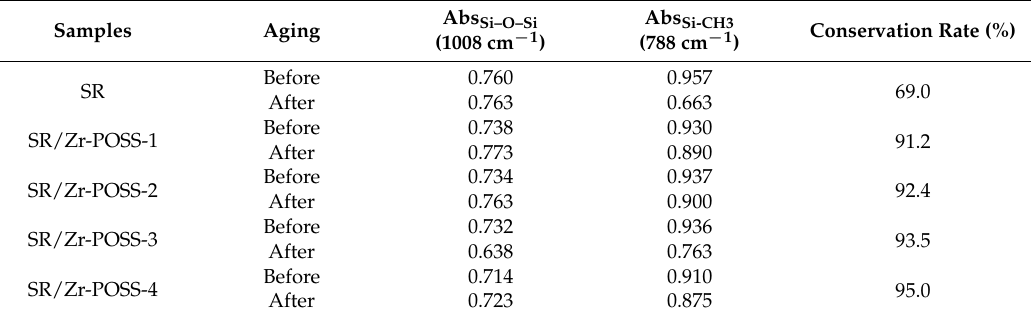
Figure 8. ATR spectra of the SR/Zr-POSS nanocomposites before and after aging. Table 3. Characteristic data obtained from